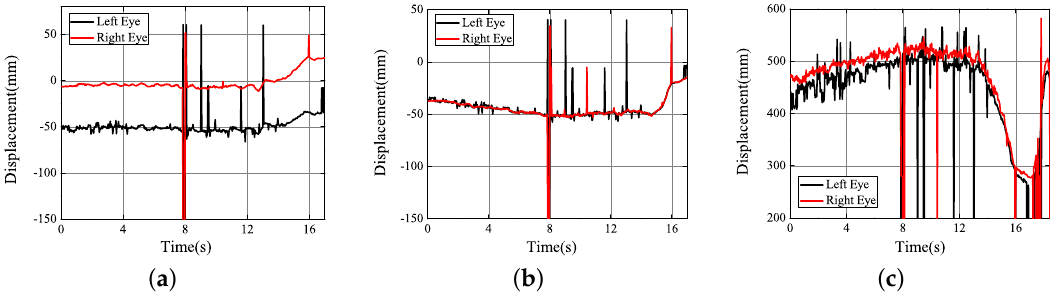
Figure 23. Experimental results obtained (40 km/h): ( a ) X axis; ( b ) Y axis; ( c ) Z axis.